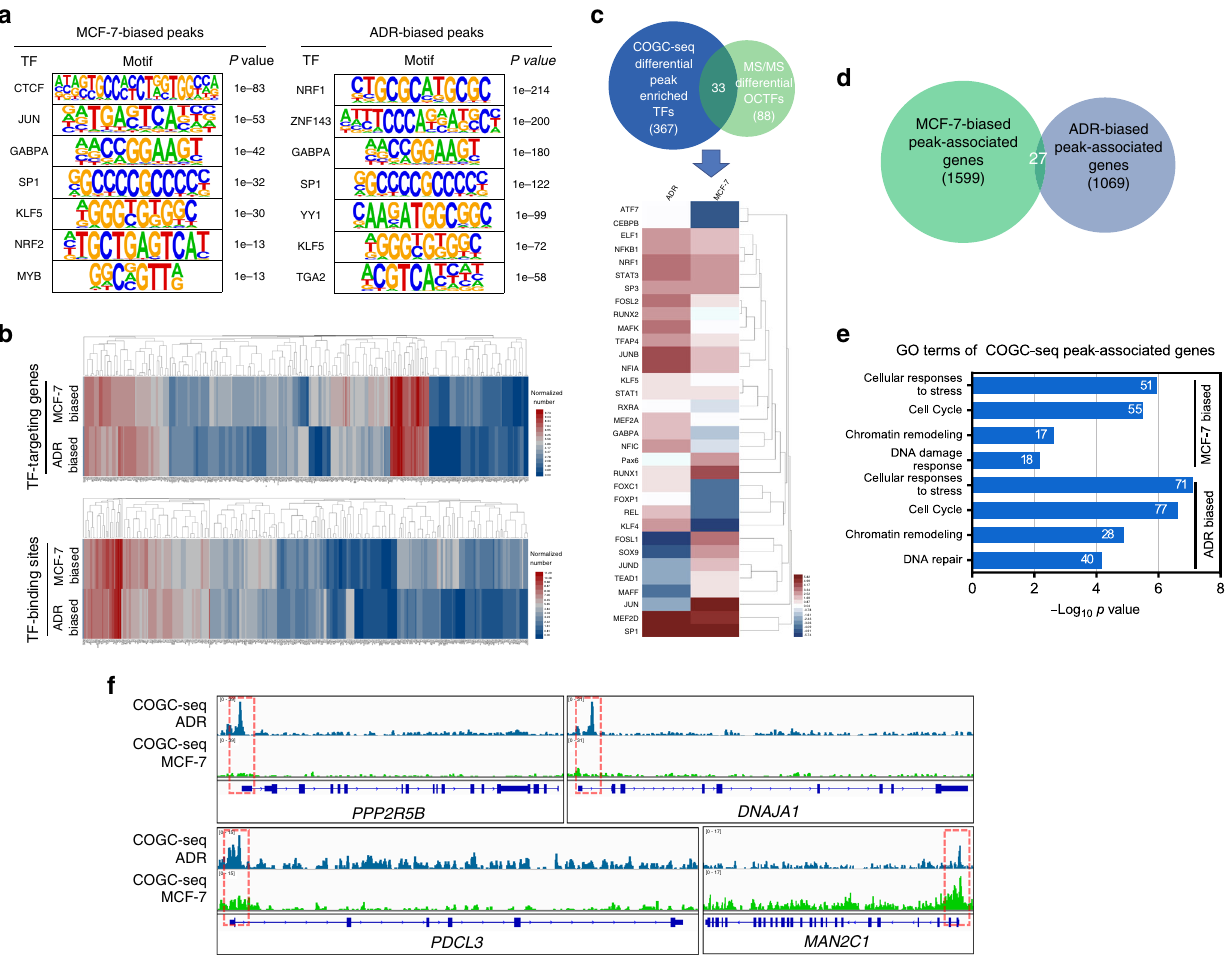
Fig. 4 OCTFs dynamically target stress response genes during the genotoxic response. a Motif discovery analysis of differential quantitative COGC-seq peaks using Homer. The binomial test P value of each motif is shown. b The chromatin binding sites and target genes of 367 putative TFs generated by the motif discovery analysis of COGC-seq peaks are shown in heat maps (red, high; blue, low). c Overlap of 367 enriched TFs identi fi ed from the motif discovery analysis with 88 differential quantitative OCTFs in MS/MS is shown in a Venn diagram. The quanti fi cation of the 33 overlapping O-GlcNAc TFs is shown in a heat map (red, high; blue, low). d Venn diagram showing the overlapped peak-associated genes identi fi ed from MCF-7 and ADR-biased COGC-seq regions. e GO analysis of MCF-7 and ADR-biased peak-associated genes. The gene numbers identi fi ed in certain terms are shown. Source Data are provided as a Source Data fi le. f Integrative Genomics Viewer (IGV) tracks showing COGC-seq signal at the promoter regions of the representative genes PPP2R5B , DNAJA1 , PDCL3 , and MAN2C1